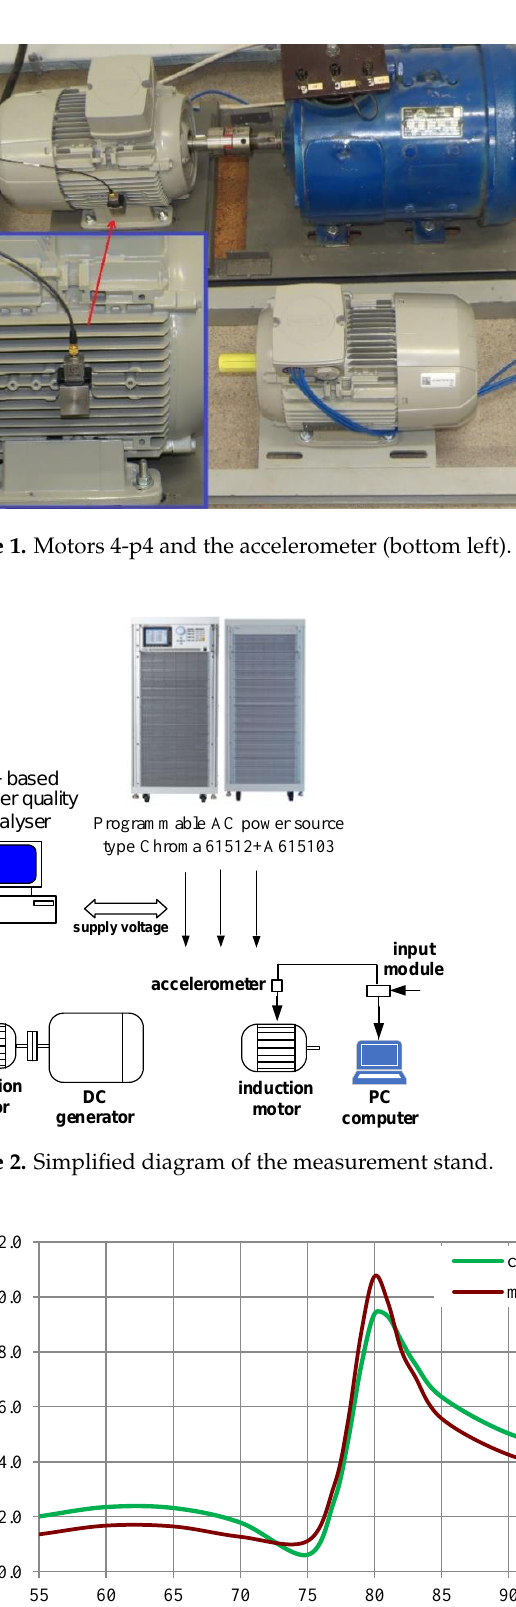
Figure 3. Measured and computed current interharmonics (related to the rated current) vs. the frequency of voltage interharmonics for motor 3-p4 and voltage containing interharmonics of value U ih = 1 % U 1 .